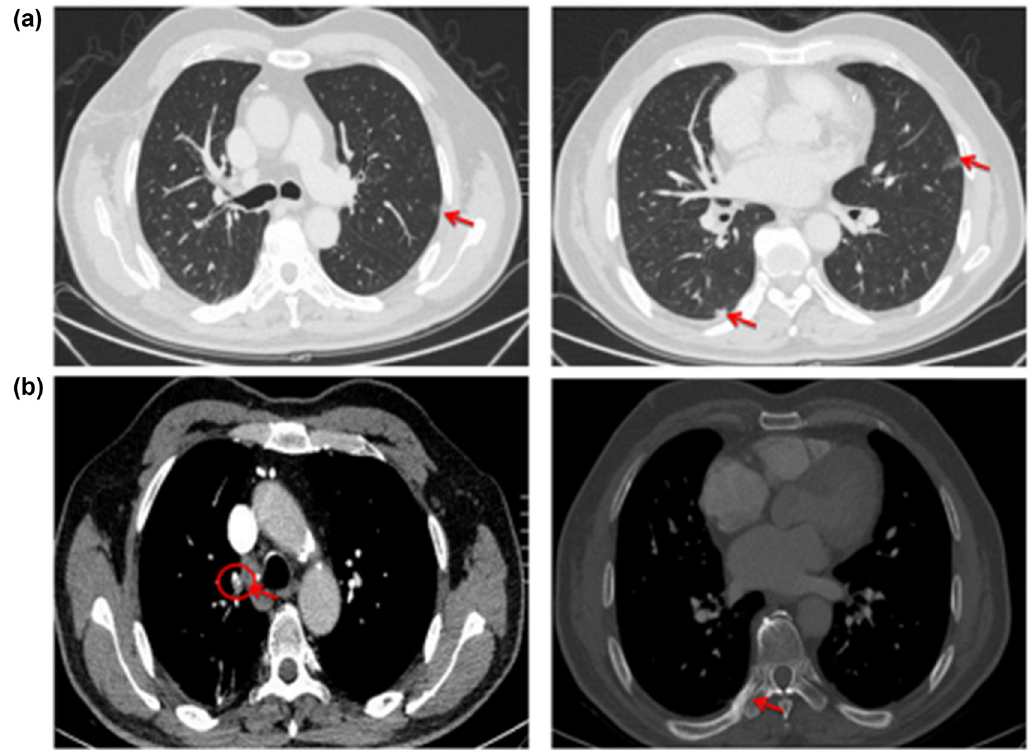
Figure 3: ( a and b ) Changes to the major tumor lesions after three courses of treatment ( October 9, 2017 ) . While there are no signi fi cant changes to the bilateral pulmonary nodules, the mediastinal lymph nodes are slightly smaller and destruction and repair of the rib bones are